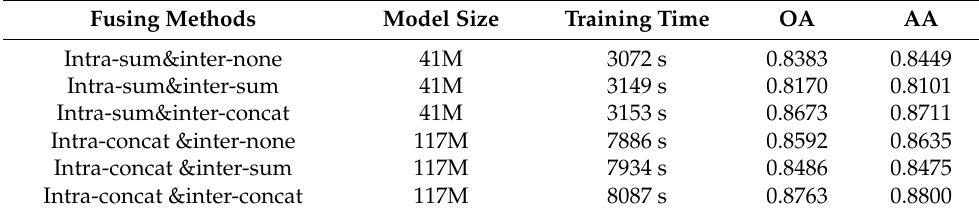
Table 3. Effect of multi-layer feature